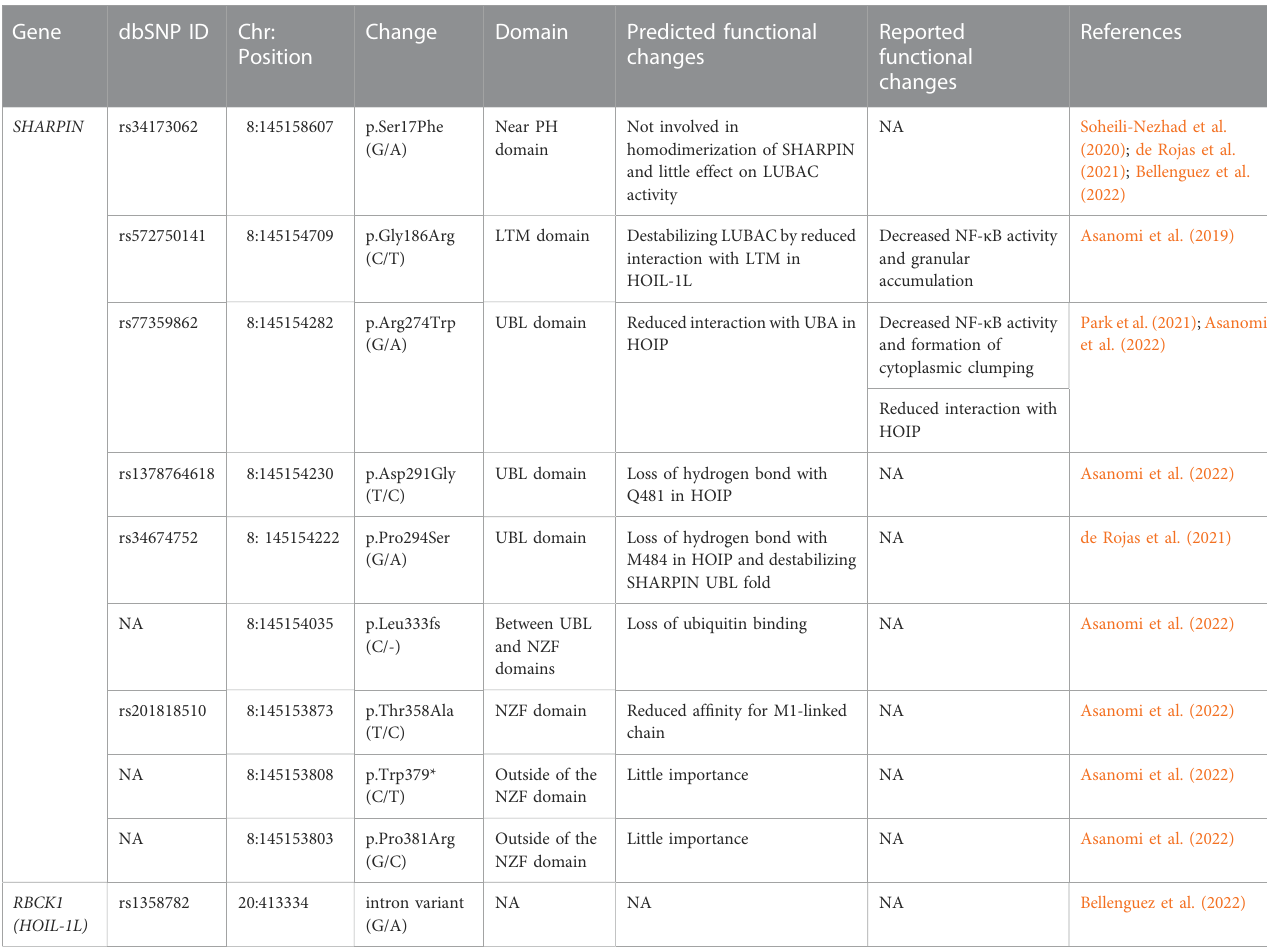
TABLE 1 AD-associated variants of SHARPIN and HOIL-1L